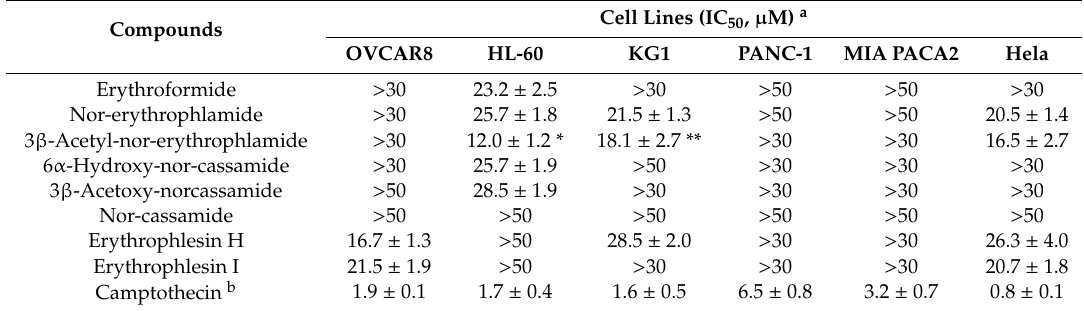
Table 1. Cytotoxic activities of cassaine diterpenoid amides from E. fordii against human leukemia cancer cell